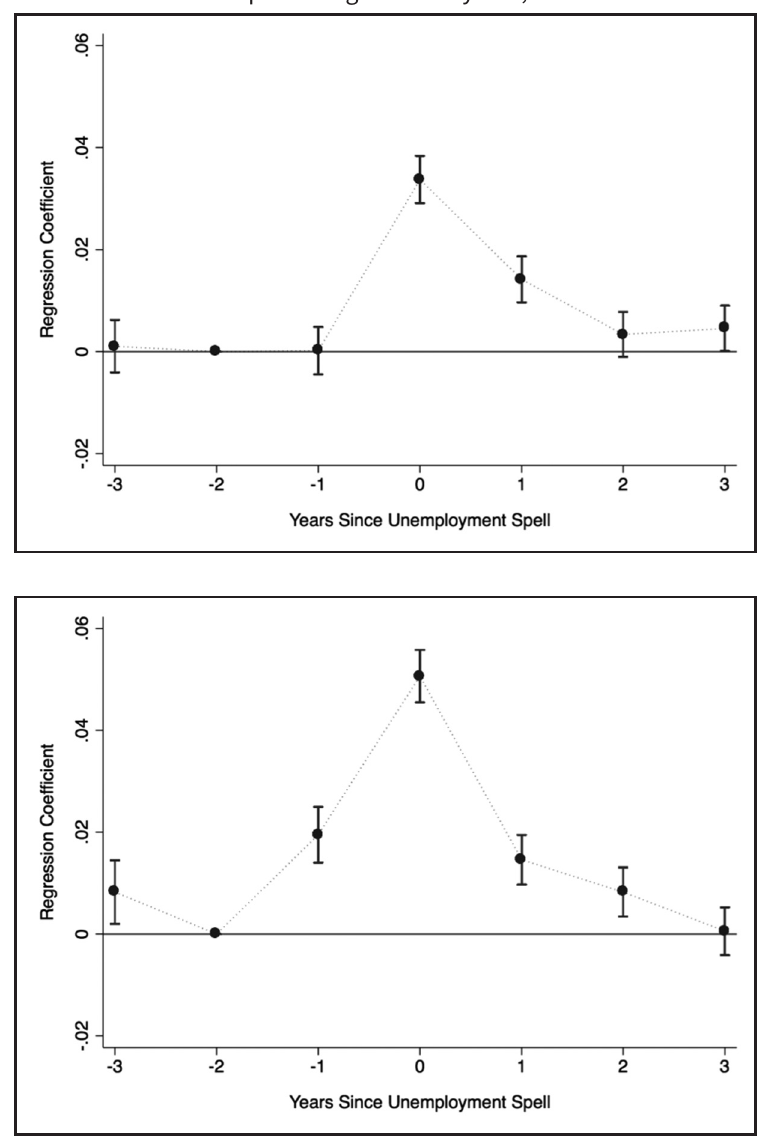
Figure 3 Coefficients from regression of family transfers on time since unemployment, spell due to displacement (top) and voluntary spell (bottom), heads of house- hold and spouses aged 19–59 years, 1976–2013